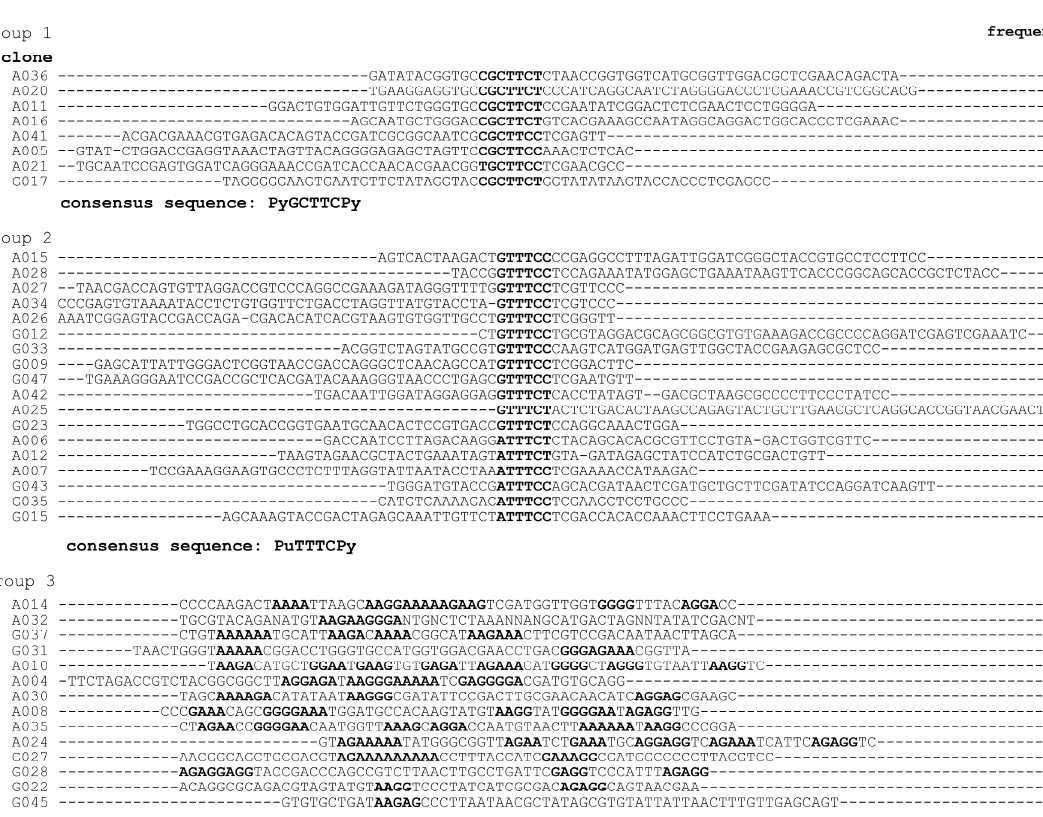
Figure 1. Sequence groups of 2 (cid:48) -F-Y-modified RNA aptamers identified by selection for binding to mLBP. About 100 individual clones were sequenced after eight rounds of selection (see Tables 1 and 2), and 44 analyzable sequences were divided into three groups based on sequence motifs. For each clone of groups 1 and 2, the sequence of the randomized region is shown and the frequency of occurrence is indicated on the right. Group 1 contained eight different clones with a common sequence motif of seven nt (5 ′ -YGCTTCY), group 2 eighteen clones with a common motif of six nucleotides (5 ′ -RTTTCY). The consensus motifs are highlighted in bold. In the orphan group 3, stretches of four or more consecutive purines are highlighted as well.